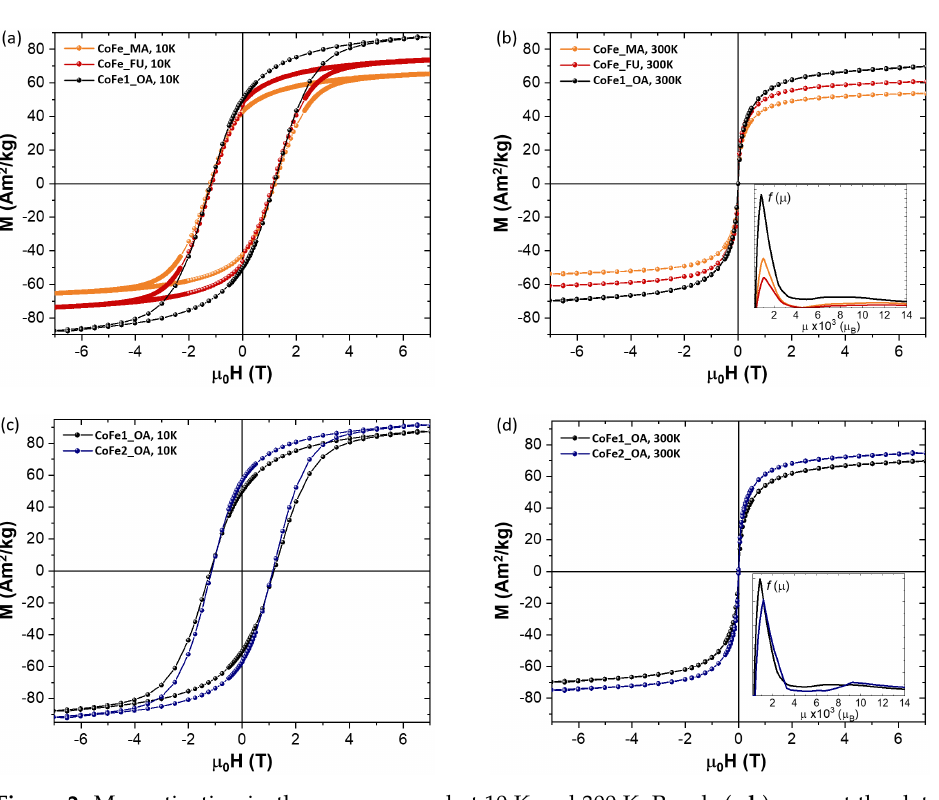
Figure 2. Magnetization isotherms measured at 10 K and 300 K. Panels ( a , b ) present the data for the MNPs based on one-step synthesis, while the panels ( c , d ) show the comparison between the MNPs obtained by the one-step and two-step protocols. The insets in panels ( b , d ) correspond to the magnetic moment distribution. Table 2. Additional magnetic parameters derived from the hysteresis loops and zero field and